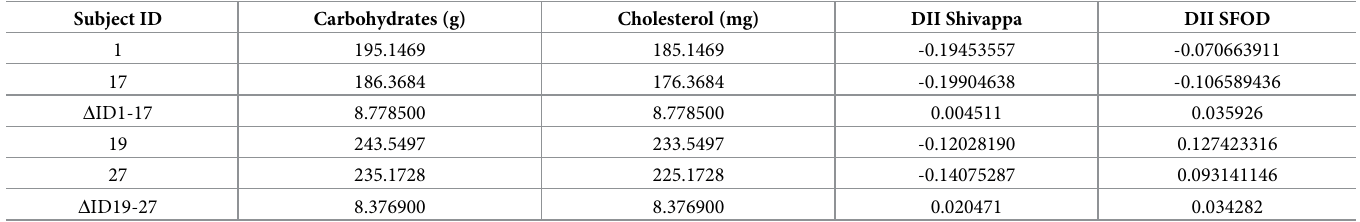
Table 2. Differences in the Dietary Inflammatory Index (DII) calculated according to Shivappa et al. [17] or the Scaling-Formula With Outlier Detection (SFOD) method based on similar food consumption data between subject